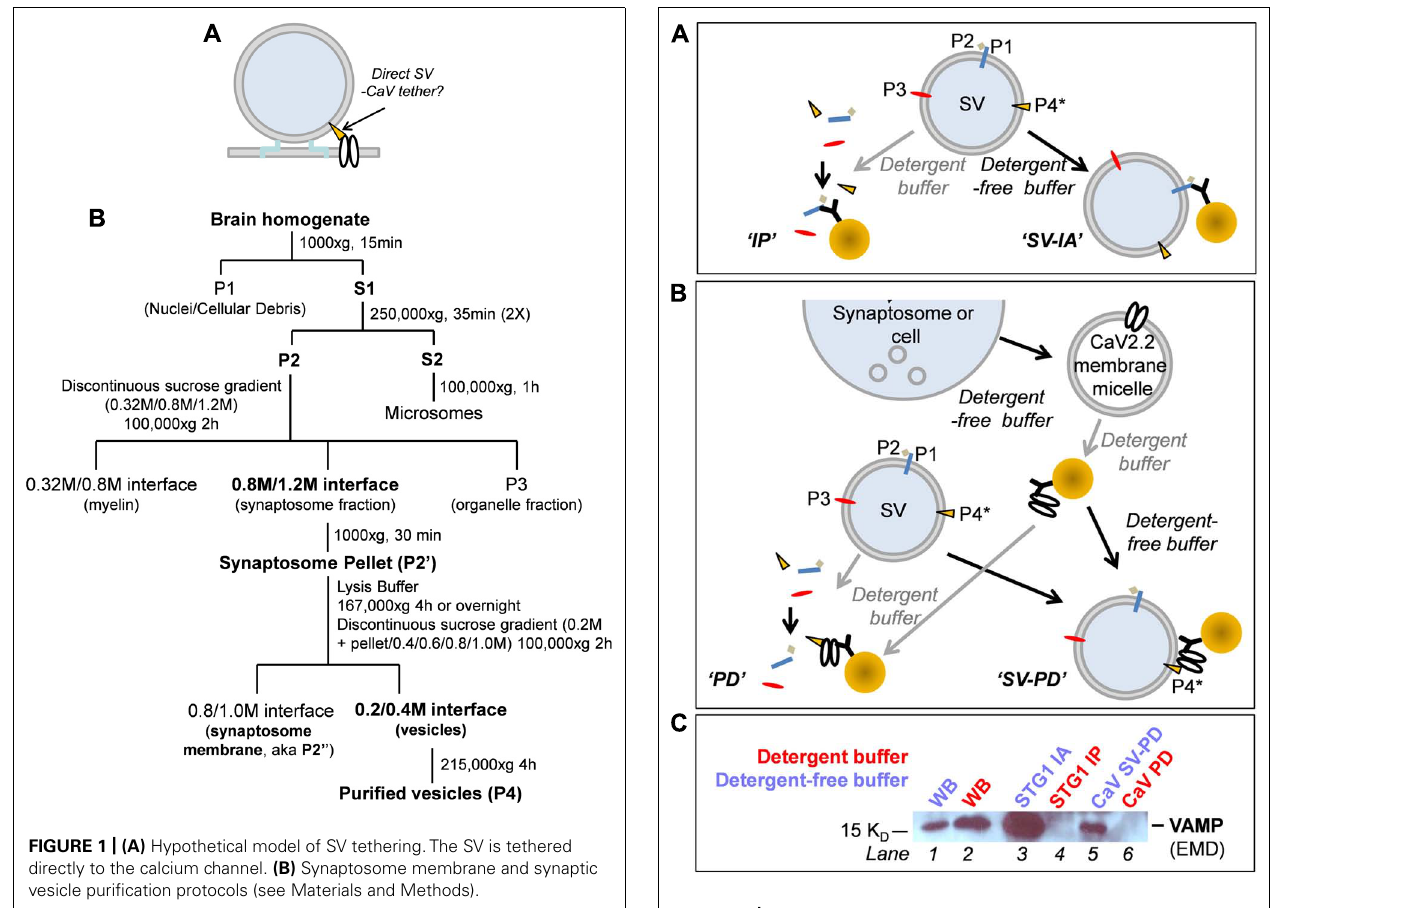
FIGURE 2 | (A–C) Biochemical methods (see text). (A) Immuno- precipitation (IP) and SV-immunoadsorption (SV-IA). P1, P2, P3, and P4 are hypothetical SV proteins. P1, P3, and P4 are integral vesicle proteins while P2 is a vesicle-associated protein (bound to an integral protein). P4 is also the putative tether attachment protein, as flagged by the asterisk. (B) Protein pull-down (PD) and whole SV pull-down (SV-PD). (C) The four methods compared using the SV protein,VAMP as the SV marker. Lanes 1 and 2:Western blot lanes demonstrateVAMP in the “detergent-free” (HB) and “detergent-containing” (RIPA buffer) samples adding ∼ 4% of the sample used for IPs. Lane 3:VAMP was detected after SVs were captured by SV-IA using anti-STG1. Lane 4: Anti-STG1 failed to captureVAMP from solubilized SVs because these two proteins are not direct binding